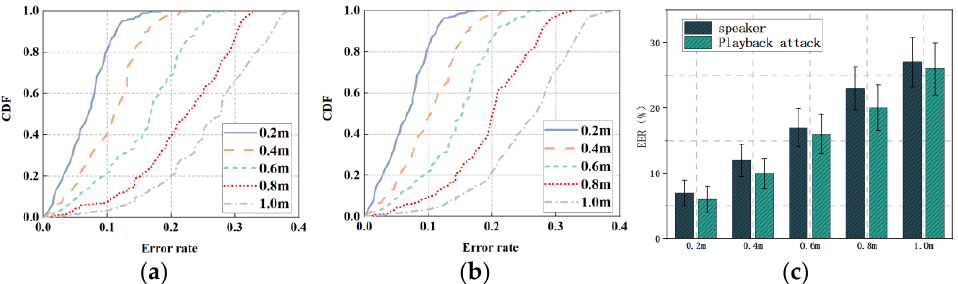
Figure 8. Different distances: ( a ) CDFs (speaker); ( b ) CDFs (playback attack); ( c ) EER.